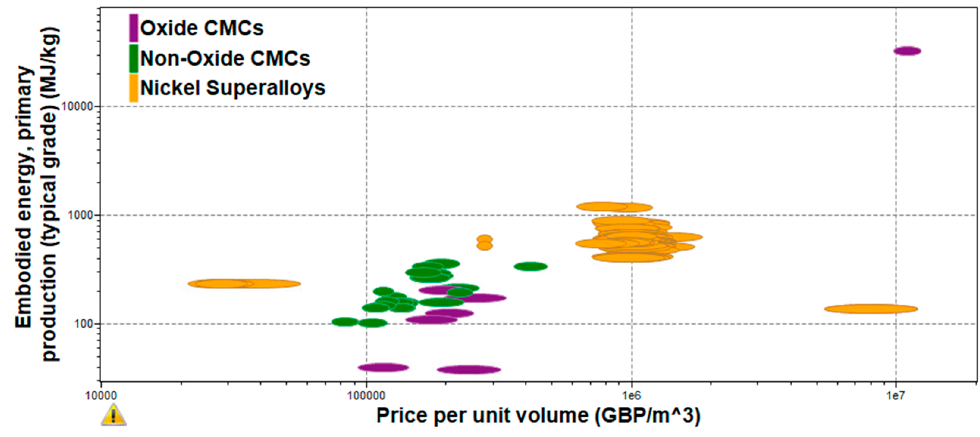
Figure 17. Embodied energy and price per unit volume of CMCs.